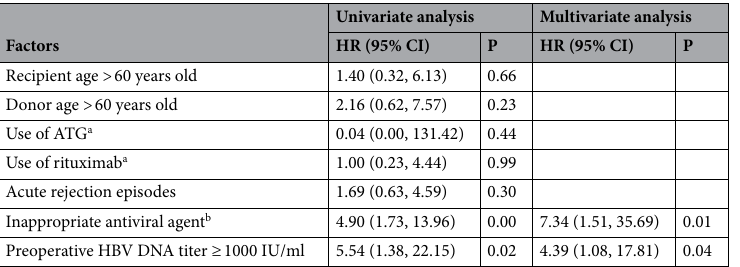
Table 3. Risk factors for HBV reactivation. ATG anti-thymocyte globulin. a ATG and rituximab for both purposes of induction and anti-rejection treatment were included. b Other than lifelong prophylactic antiviral therapy.